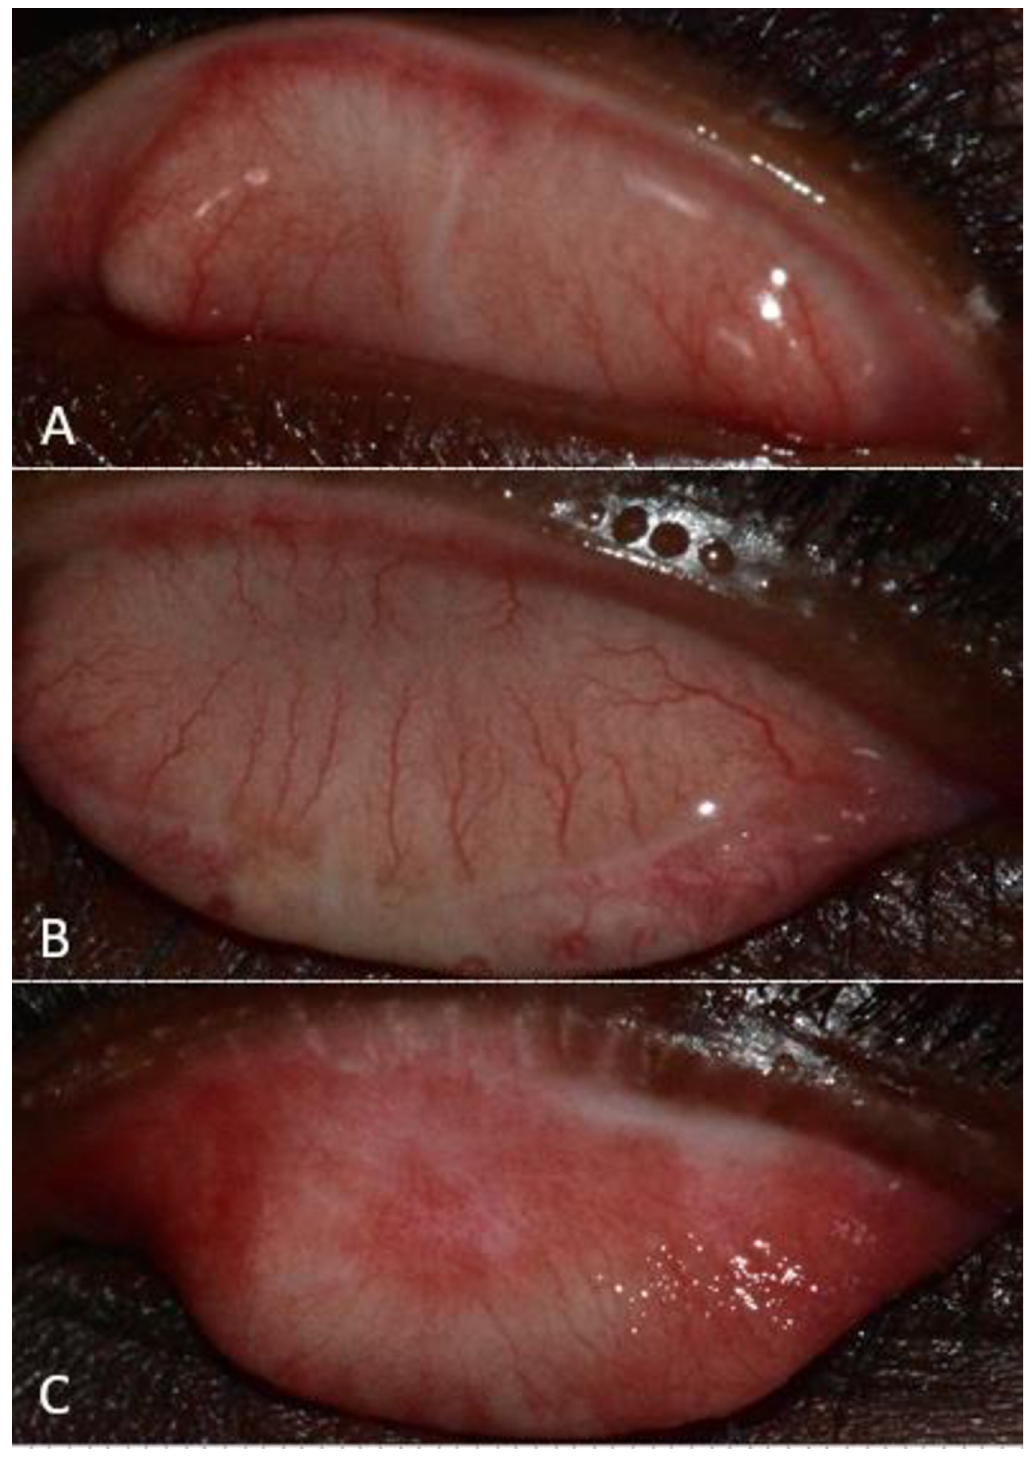
Fig 2. Conjunctival photographs demonstrating three grades of incident scarring in the study cohort. (A) Mild scarring (grade S1); a single linear scar is present. (B) Moderate scarring (grade S2); linear scarring spanning the width of the inner surface of the eyelid. Severe scarring (grade S3); diffuse meshwork of scarring over the conjunctival surface.